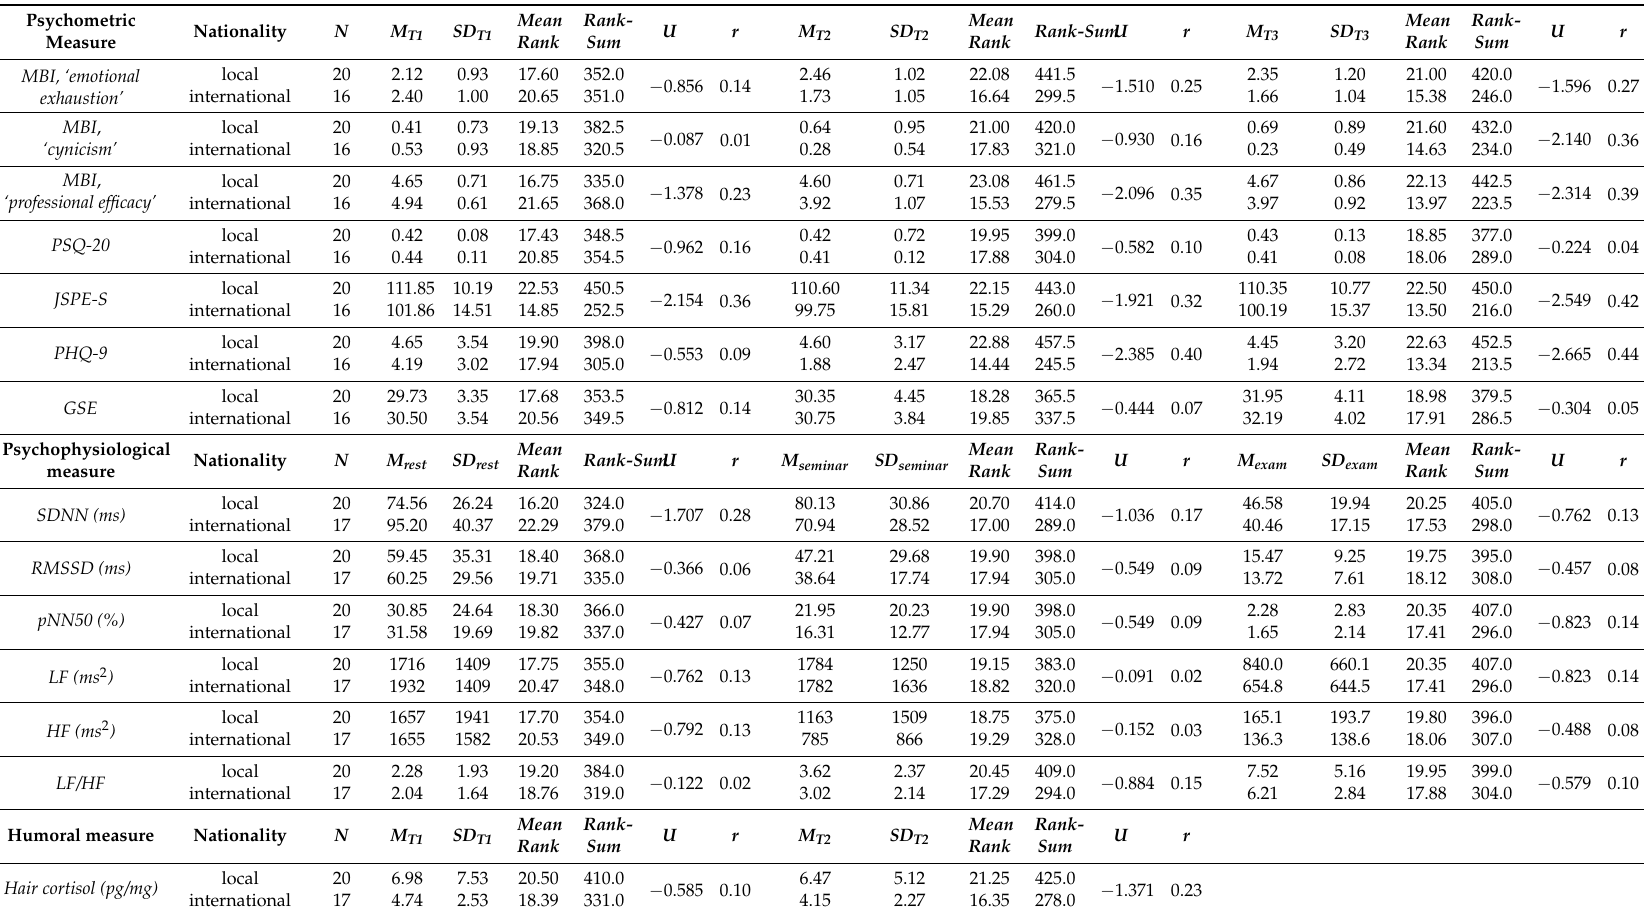
Table 2. Mann–Whitney U Tests for differences in local and international